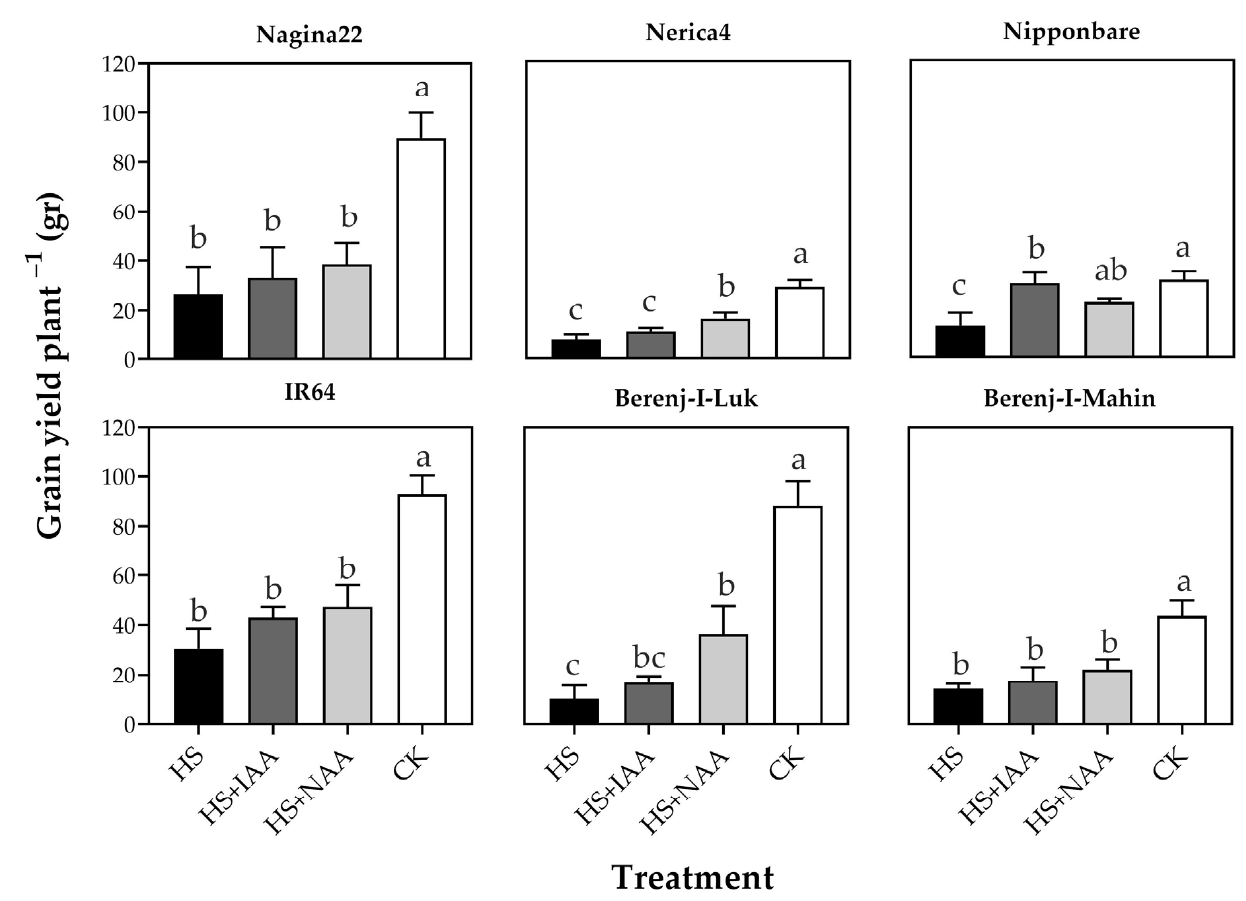
Figure 4. Grain yield per plant of different rice genotypes under heat stress, auxin application treatment, and control conditions. Vertical error bars denote the standard error ( n = 5). Different letters indicate significant differences among four treatments for the same genotypes at the p < 0.05 level. Table 2. Yield components of six rice genotypes under HS, HS + IAA, HS + NAA, and CK conditions.